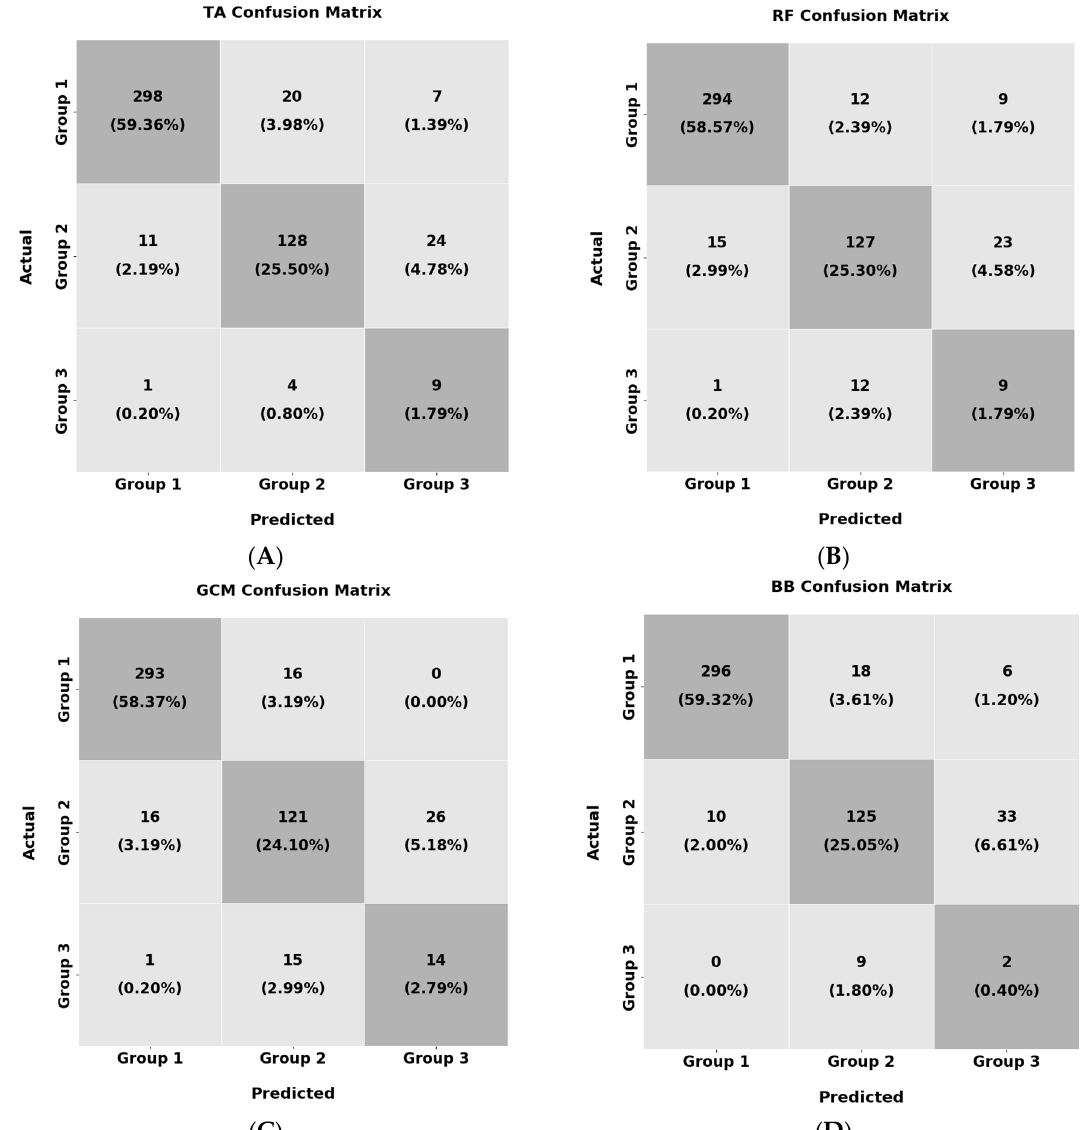
Figure 14. Confusion matrices for the group classification for the ( A ) T.A., ( B ) R.F., ( C ) GCM, and ( D ) B.B.